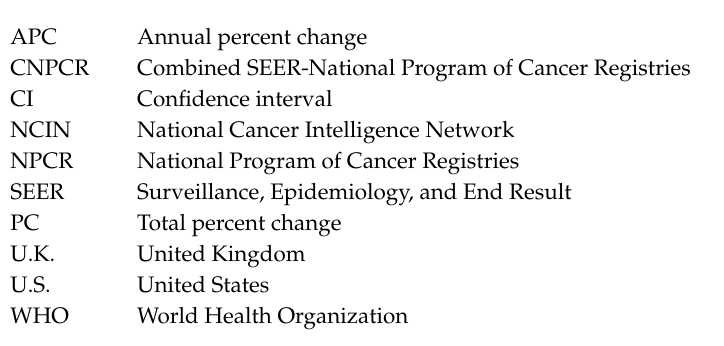
Figure S1: Age-specific rates of liposarcoma 2001–2016 from Surveillance, Epidemiology, and End Result (SEER) and combined SEER–National Program of Cancer Registries (CNPCR) data; Table S1: Distribution of